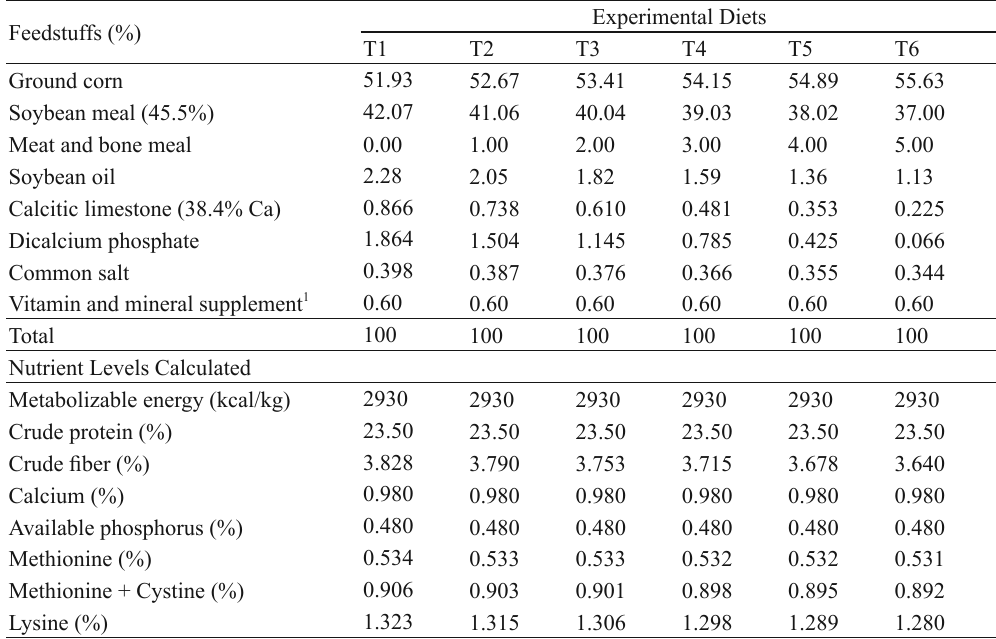
Percent composition of feedstuffs and calculated nutrient levels of the experimental diets for Japanese quail during the starter